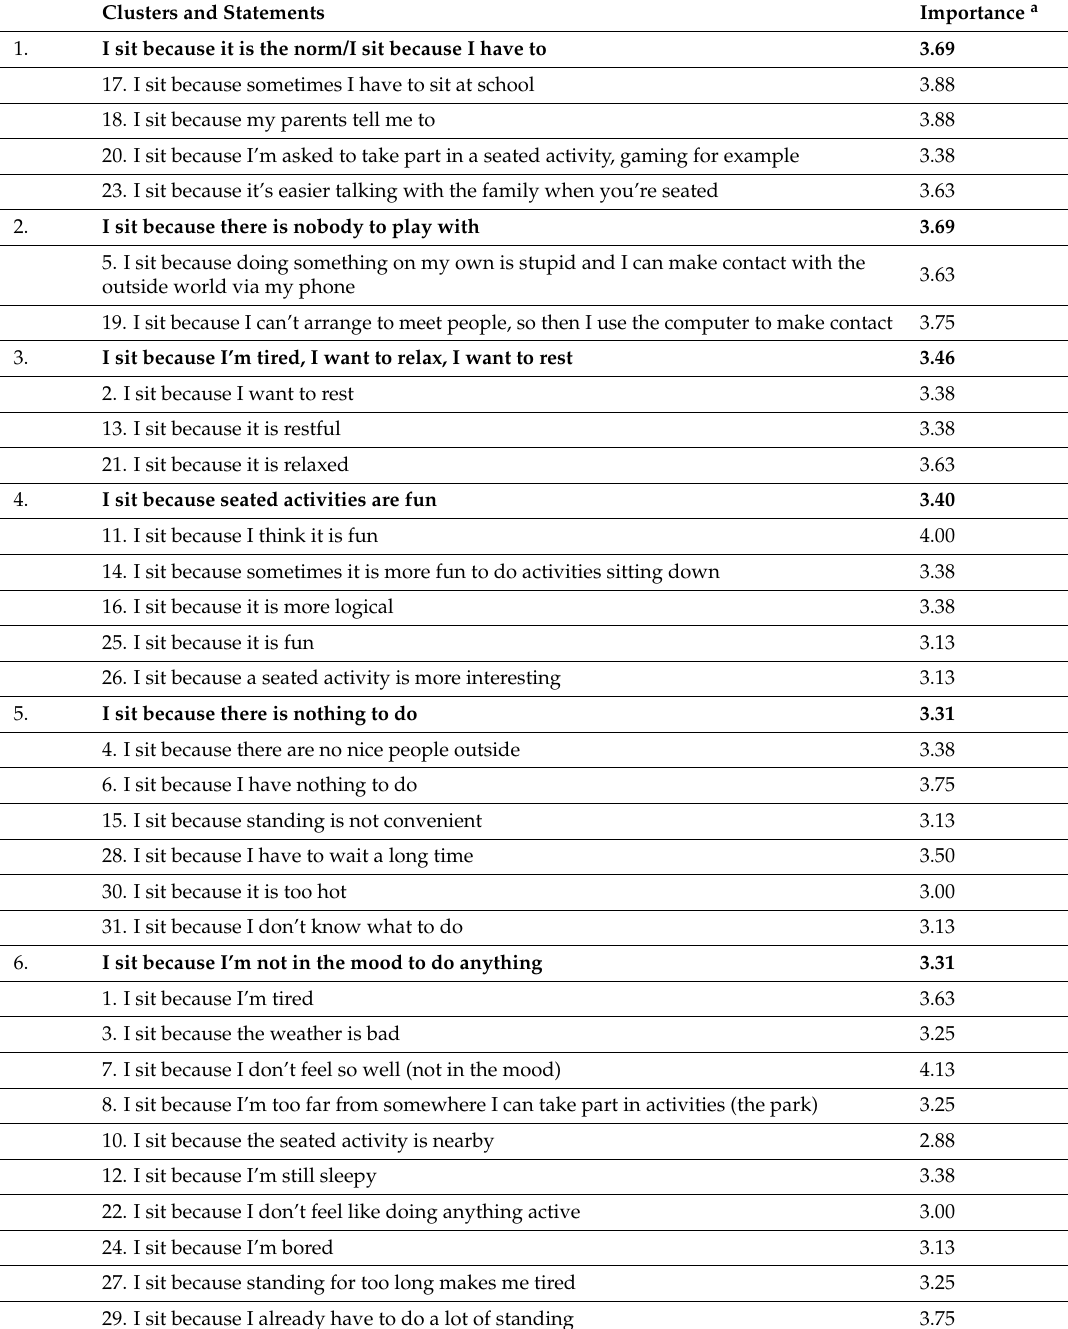
Table A3. Clusters, statements and importance ratings of children (school